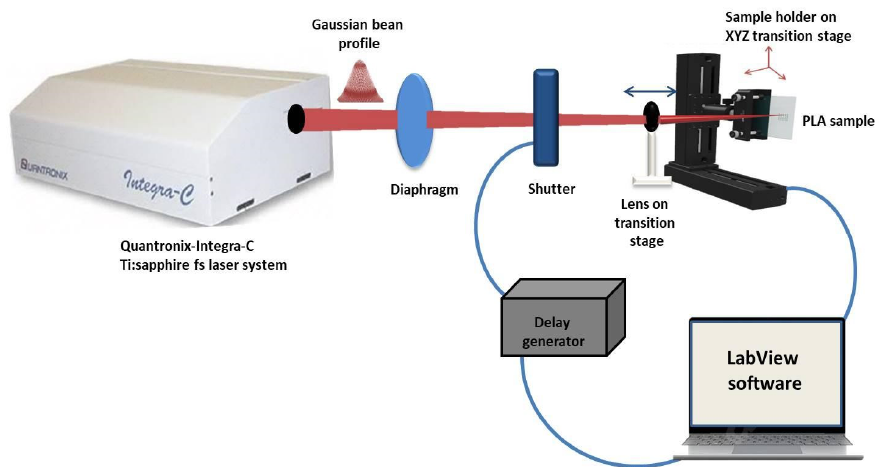
Figure 1. A scheme of the optical setup for Fs laser patterning of PLA sample positioned perpendic- ular to the laser beam on XYZ translation stage.